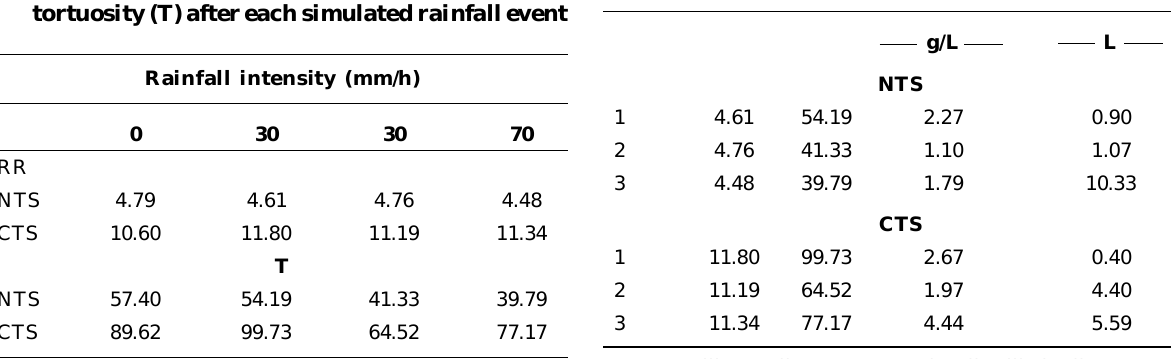
Table 4. Mean values of randon roughness (RR), tortuosity (T), soil loss, and water loss after the simulated rain events (intensity 30, 30 and 70 Rain